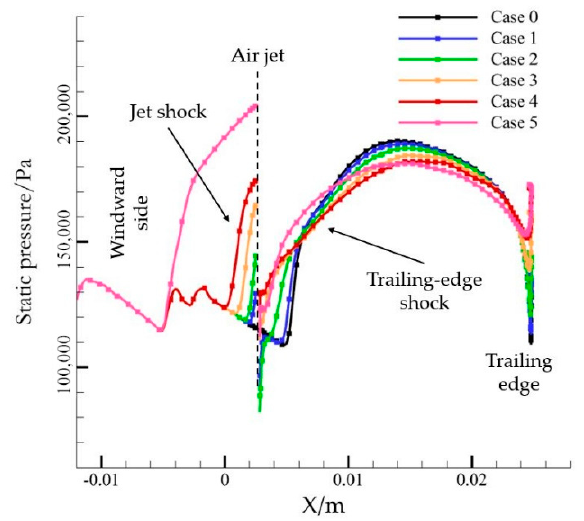
Figure 10. Static pressure distribution on blade surface with different strengths of jet.